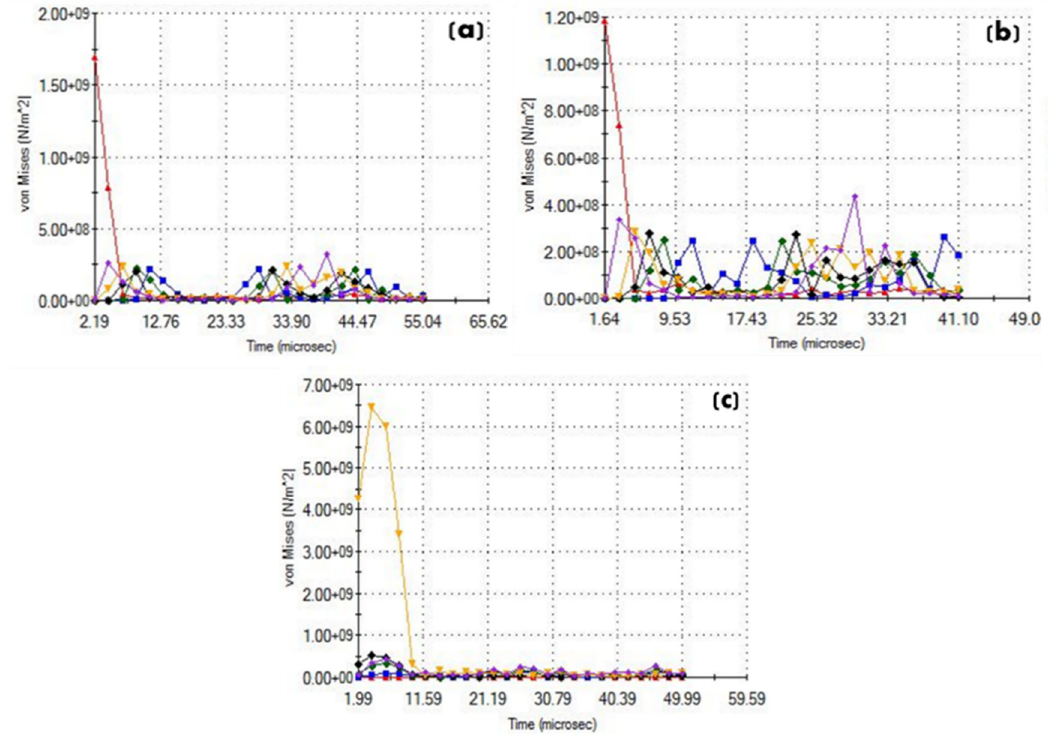
Figure 8. Maximum stresses at the tip, various central points and at the base of each arrowhead geometry as a function of time. Each arrowhead is simulated using iron in order to compare only the effects of geometry: ( a ) root geometry, ( b ) bone geometry and ( c ) iron geometry.